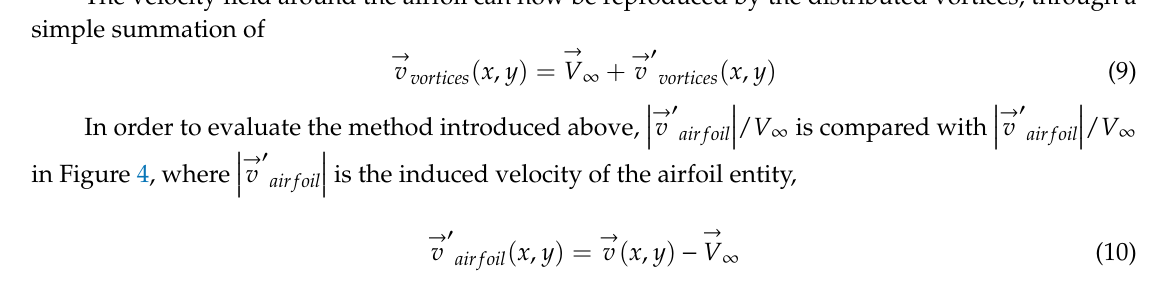
(cid:12) (cid:12) (cid:48) → (cid:12) (cid:12) ′  v V (cid:12) (cid:12) (Airfoil S809, 6 α= ° , Reynolds number = v ∞ vortices (cid:12) (cid:12) / V ∞ (Airfoil S809, vortices